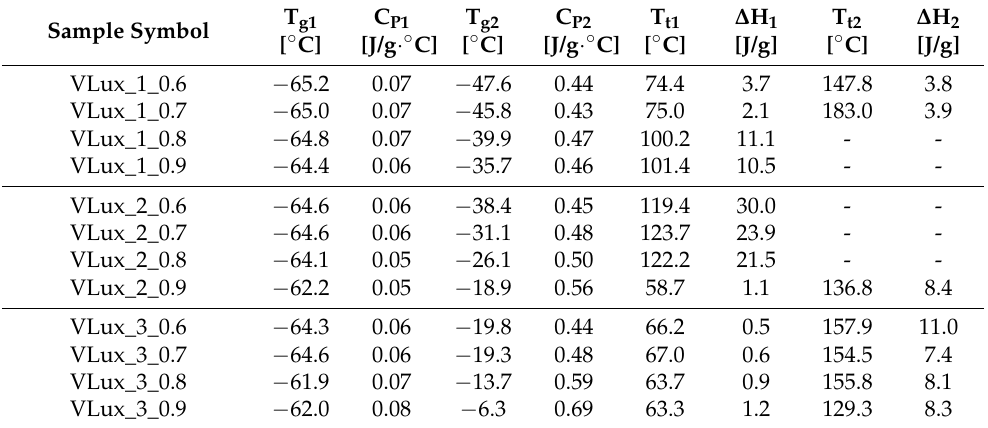
Table 5. Differential scanning calorimetry DSC results obtained from the first heating